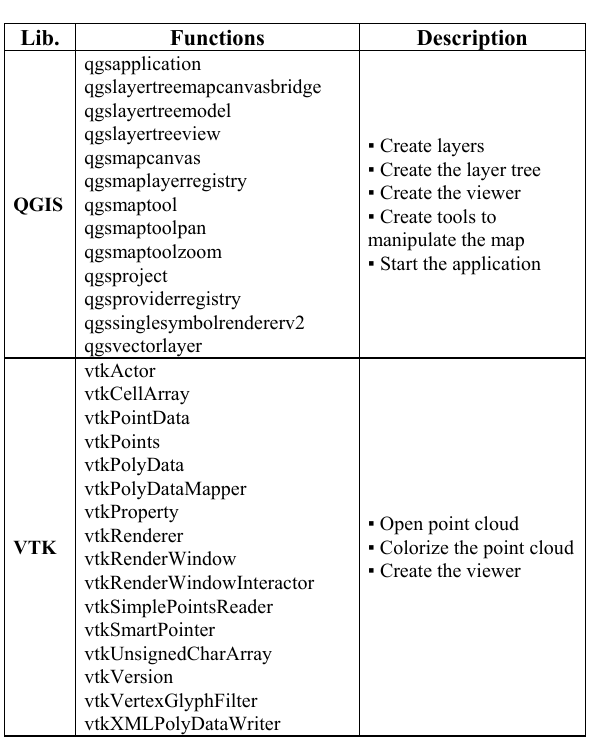
Table 3. Examples of functionalities implemented and the libraries employed.